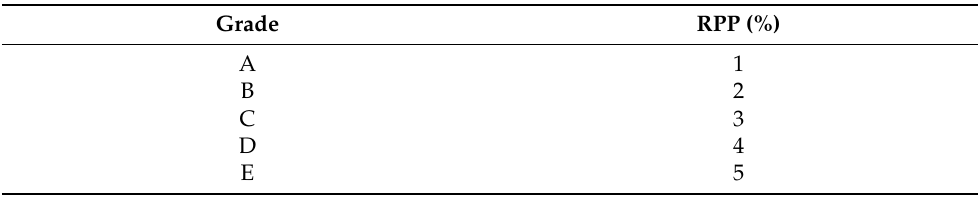
Table 6. RPP content of modified asphalt.